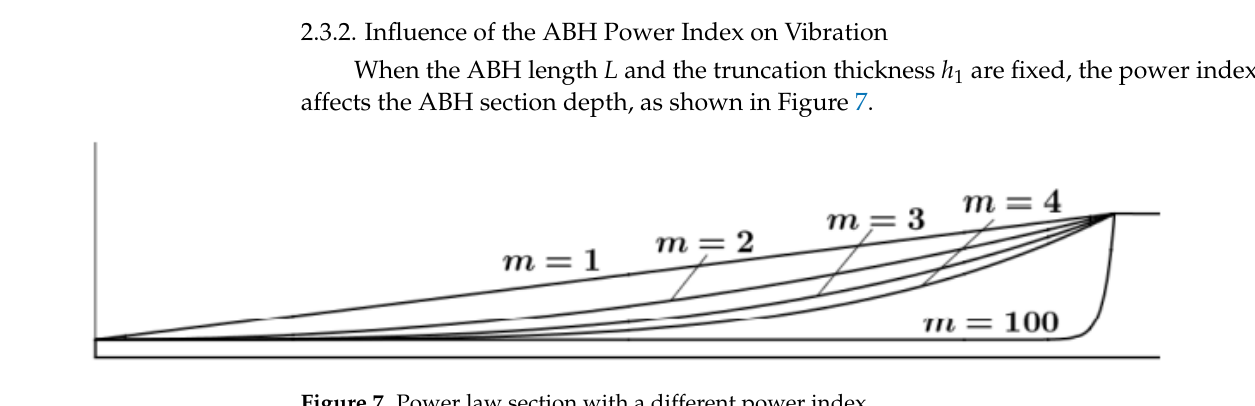
Figure 7. Power law section with a different power index.